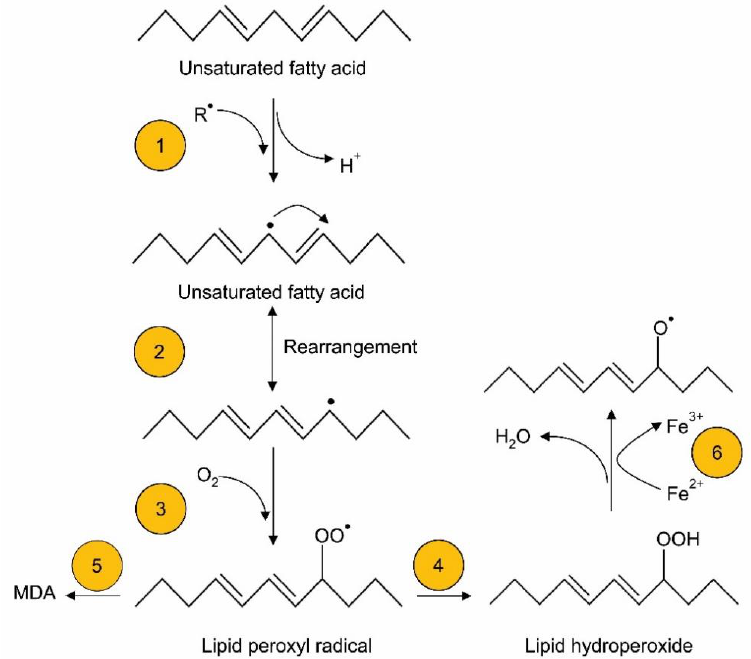
Figure 2. Lipid peroxidation of unsaturated fatty acids. Step 1: abstraction of a proton by free radicals, generating a carbon-centered lipid radical. Step 2: molecular rearrangement to generate a stabilized conjugated diene. Step 3: oxygen reacts with an unsaturated fatty acid radical to form a lipid peroxyl radical. Step 4: the lipid peroxyl radical abstracts H + from another source to generate lipid hydroperoxide. Step 5: the lipid peroxyl radical breaks down to form aldehydes, including malondialdehyde (MDA), 4-hydroxy-2-nonenal (from omega-6 fatty acids) and 4-hydroxy-2-hexanal (from omega-3 fatty acids). Step 6: lipid hydroperoxides can react with Fe 2+ via Fenton-type reactions, producing LO • radicals.